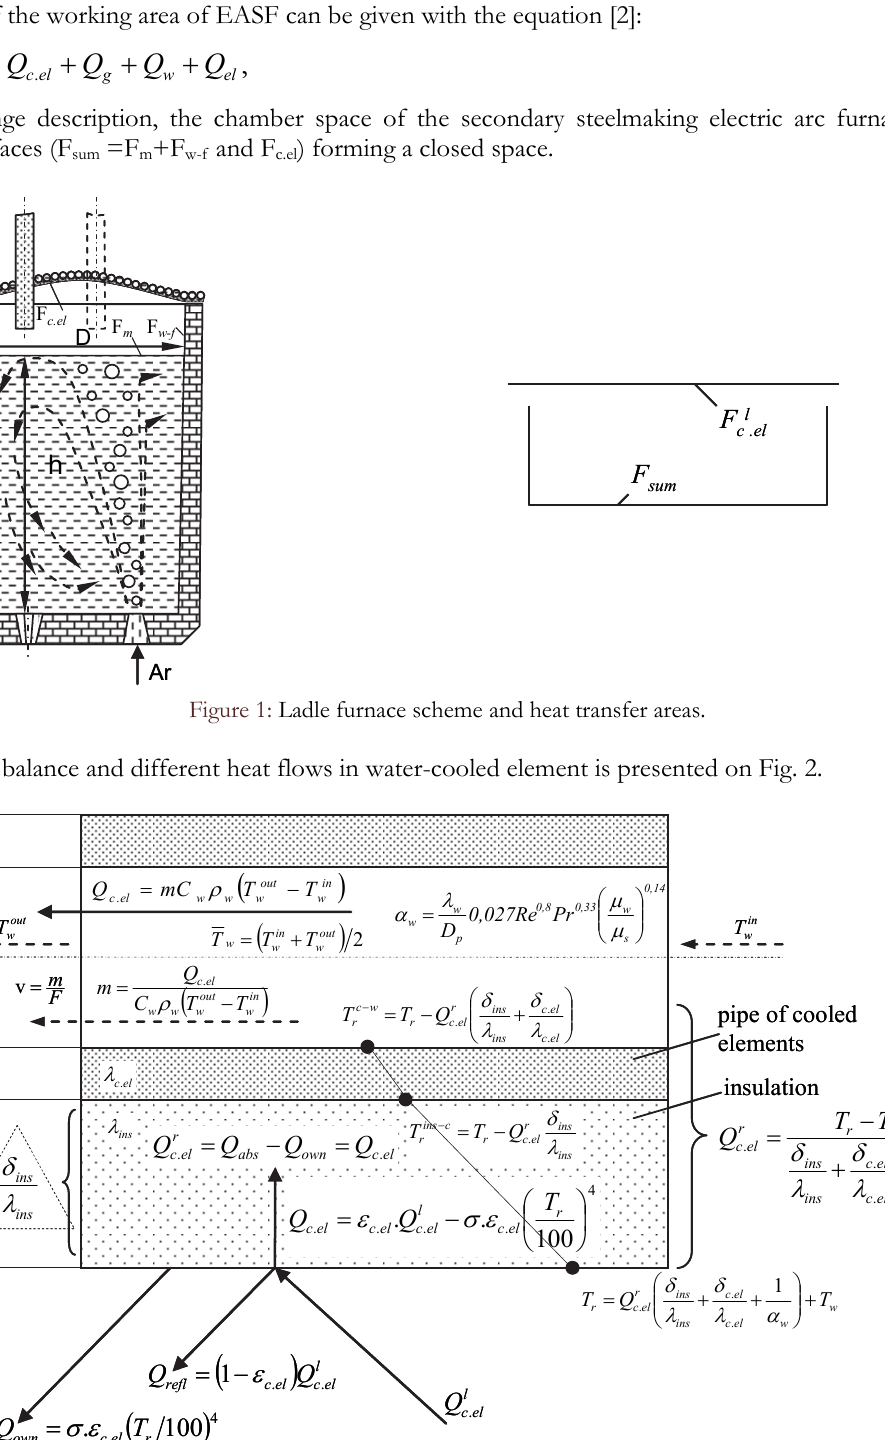
Figure 2: Scheme of the heat balance and different heat flows in